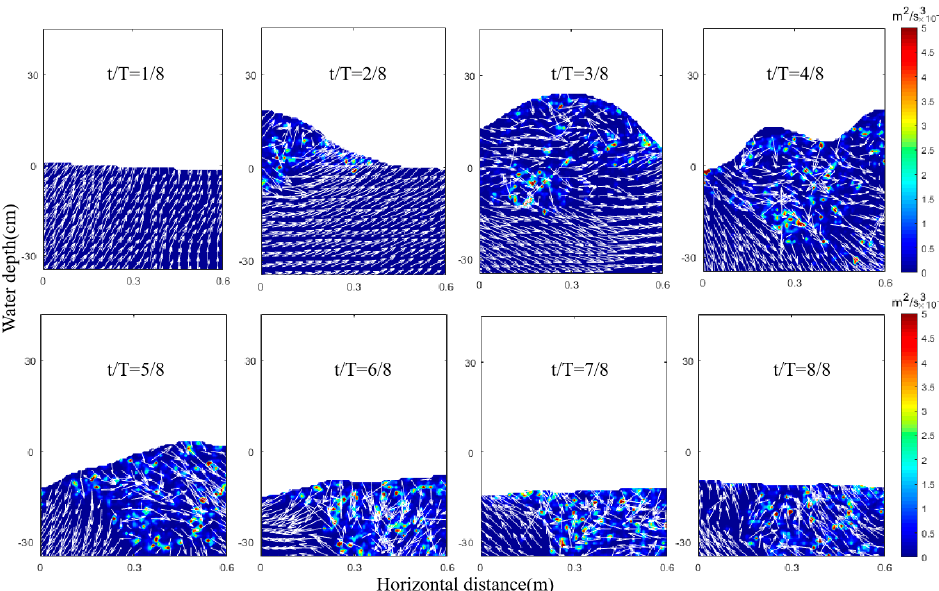
Figure 16. Spatial distribution of turbulent dissipation rate for 15 cm breaking wave.